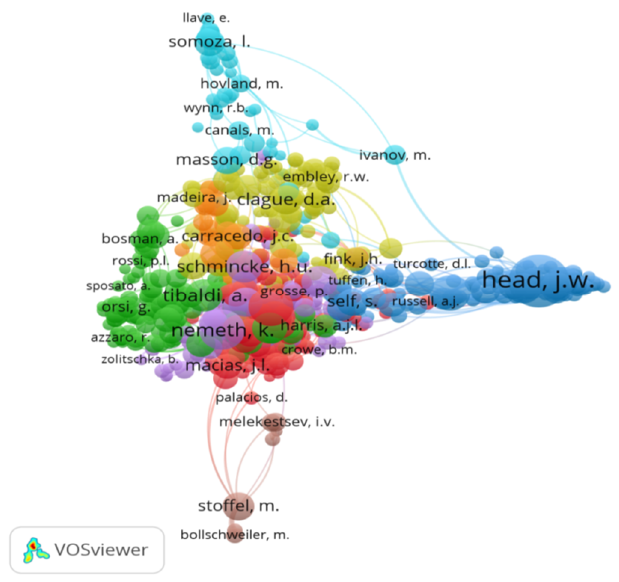
Figure 4. Co-citation bibliometric map of cited authors.